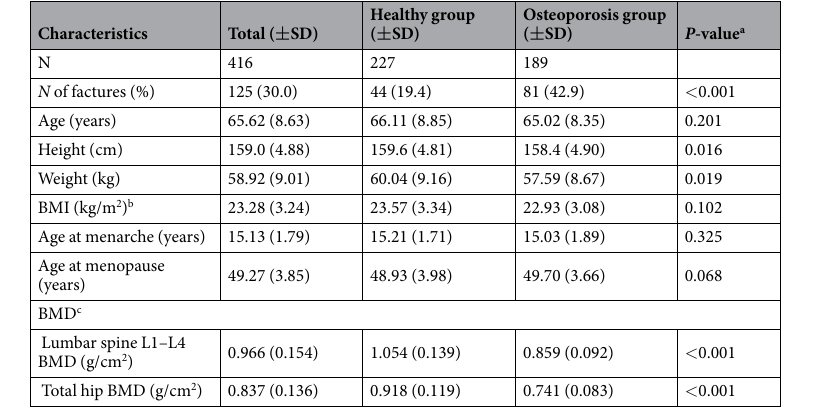
Table 1. Demographical and clinical characteristics of 416 postmenopausal women in this study. a Healthy vs osteoporosis group; b BMI, body mass index; c BMD, bone mineral